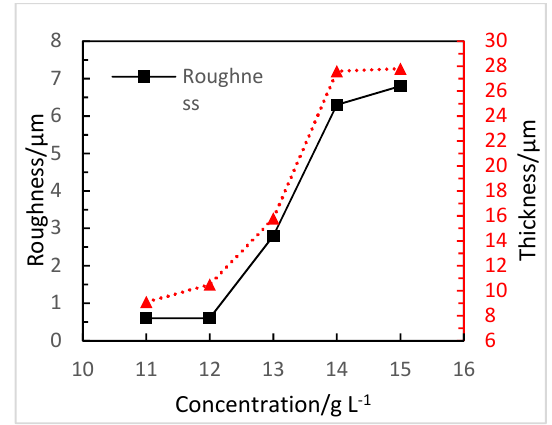
Figure 4. Influence of sodium silicate concentration (11–15 g L − 1 ) on thickness and roughness of the MAO film.